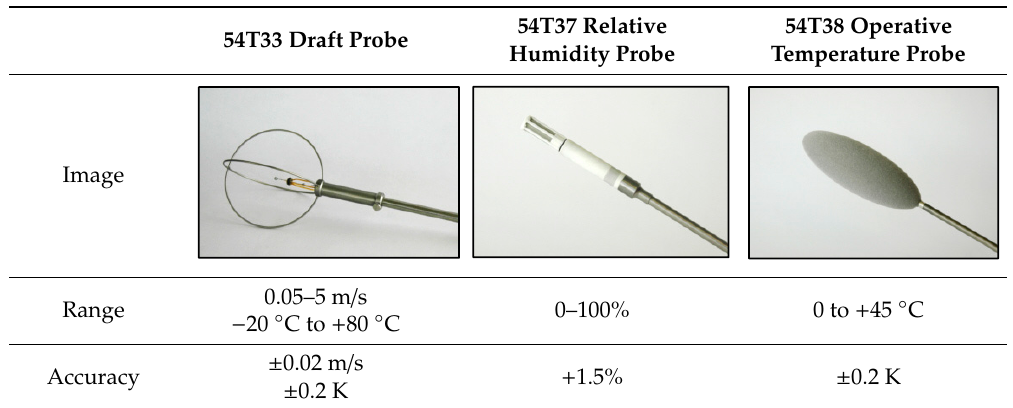
Table 3. Specifications of measuring equipment [56].